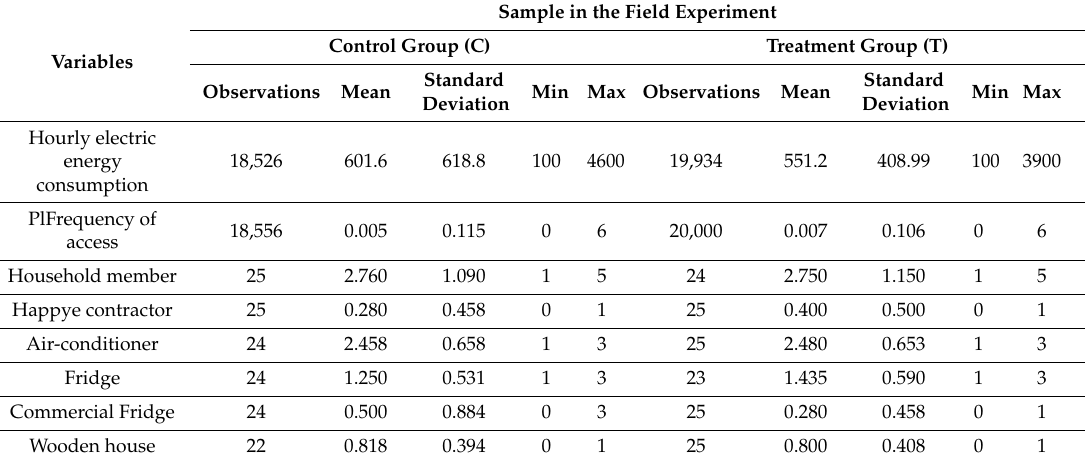
Table 1. Descriptive Statistics.